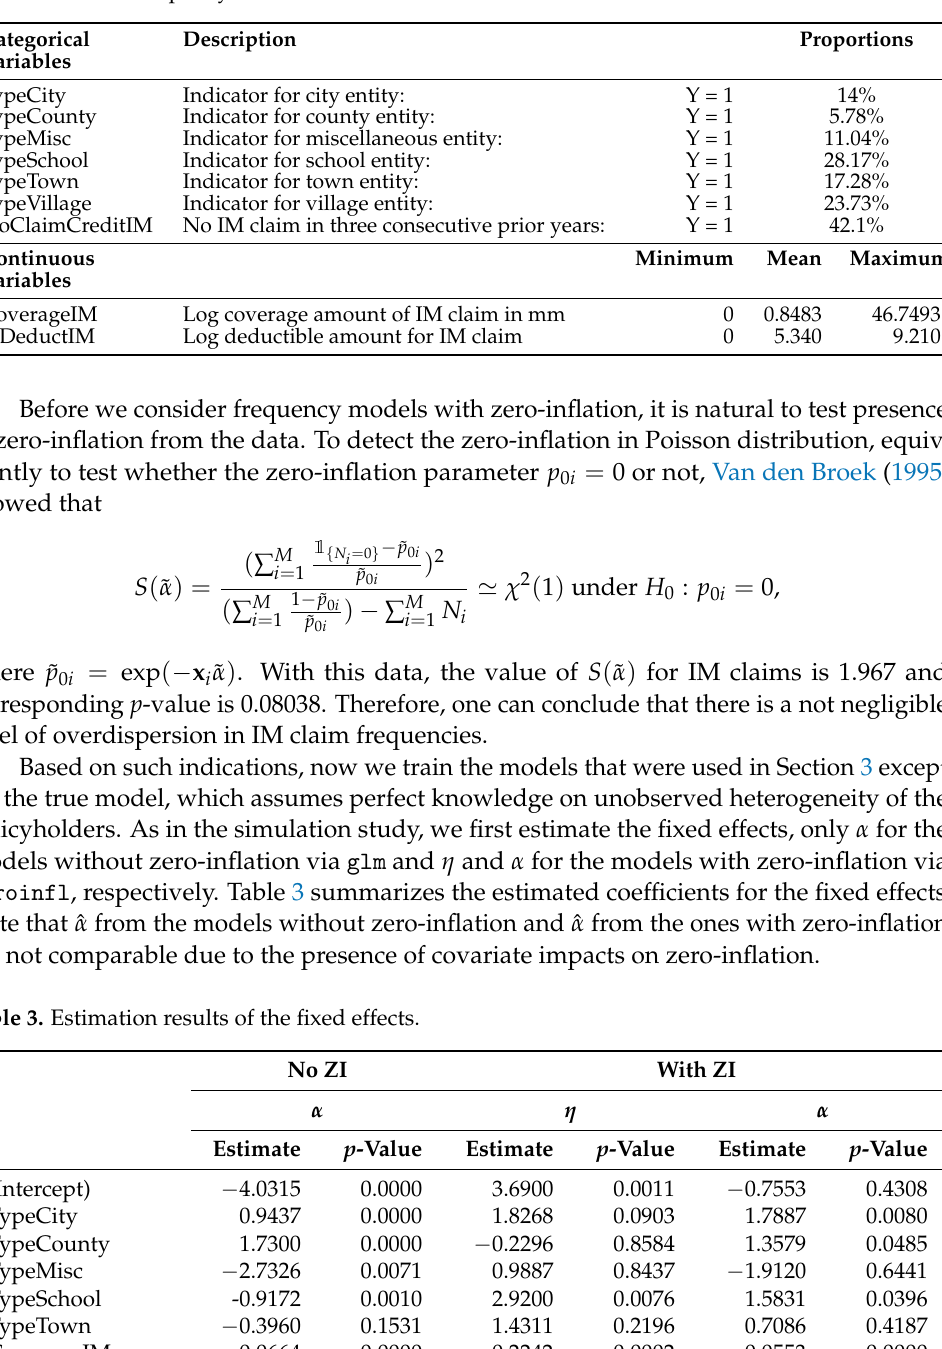
Table 2. Observable policy characteristics used as covariates.